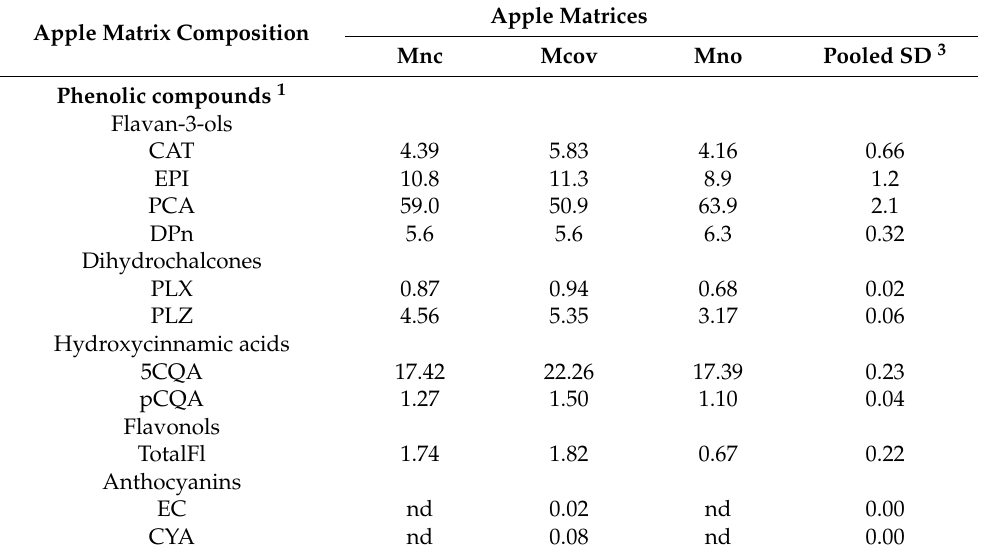
Table 1. Composition in phenolic compounds (% w / w ) and cell wall compounds (mg · g − 1 AIS) of the studied apple matrices prepared from Bedan and Reinette de Flandre